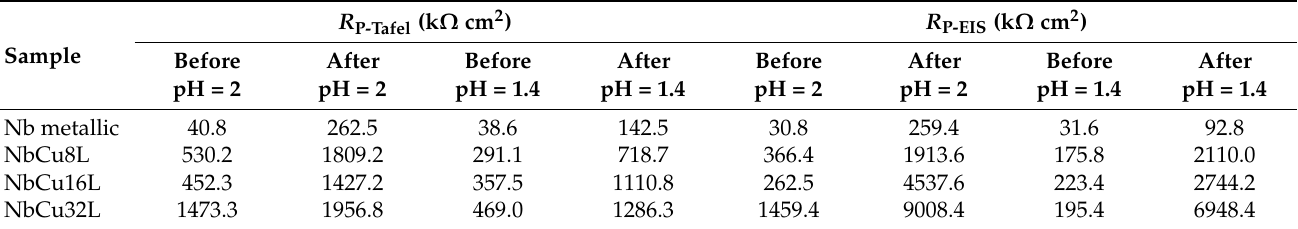
Table 5. Polarization resistance values determined by Tafel extrapolation and EIS fitting for metallic Nb and Nb coatings on copper in O 2 -saturated solutions at pH = 2 and pH = 1.4.